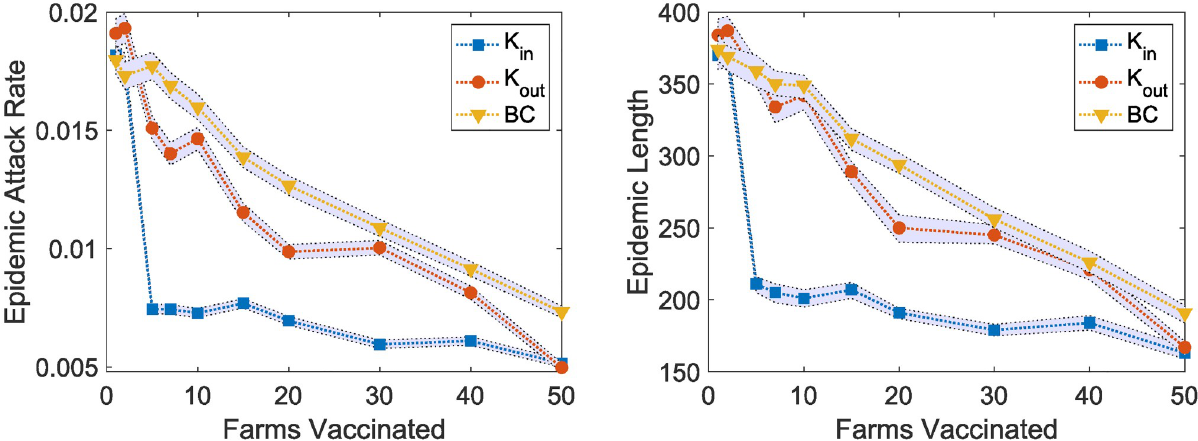
Fig 7. Comparison of different targeted vaccination schemes based on farm node centrality measures. Three different vaccination strategies (high in degree, K , high out degree, K , and high betweenness, BC ) are compared. For each strategy, different number of farms are immunized from a in out centrality based sorted descending list. The hypothetical vaccines are 80% effective. The left plot shows the epidemic attack rates and the right plot shows the epidemic lengths. The data points are mean values computed from 10,000 stochastic simulations and the shaded regions show 95% confidence